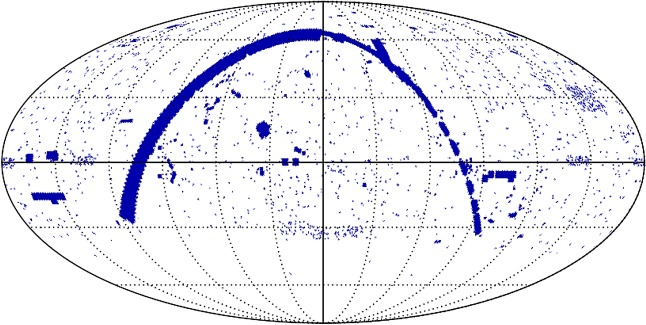
The areas of sky observed by SCUBA-2 up until December 2016, dominated by areas in or near the Galactic Plane. Figure courtesy of Graham Bell (EAO).